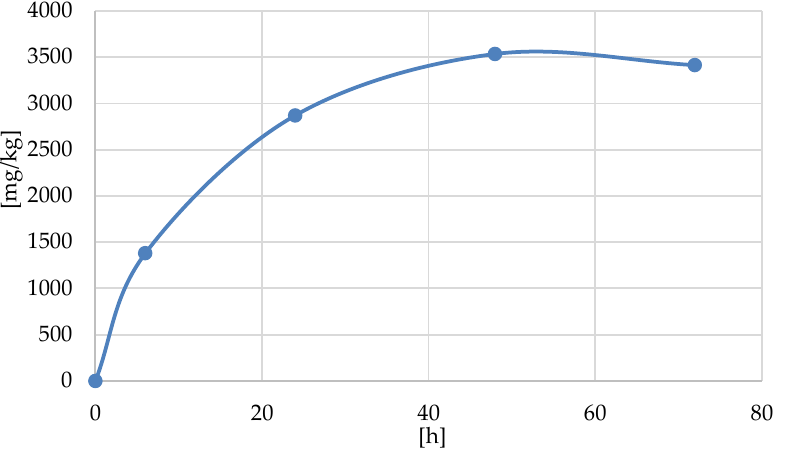
Figure 14. The course of phosphorylation of cellulose by PCl 3 (Cell-OH → Cell- O 6 -PCl 2 → Cell- O 6 -P(O)(OH)-H) obtained on the basis of phosphorus determination in phosphorylated samples Cell- O 6 -P(O)(OH)-H(t[h]).